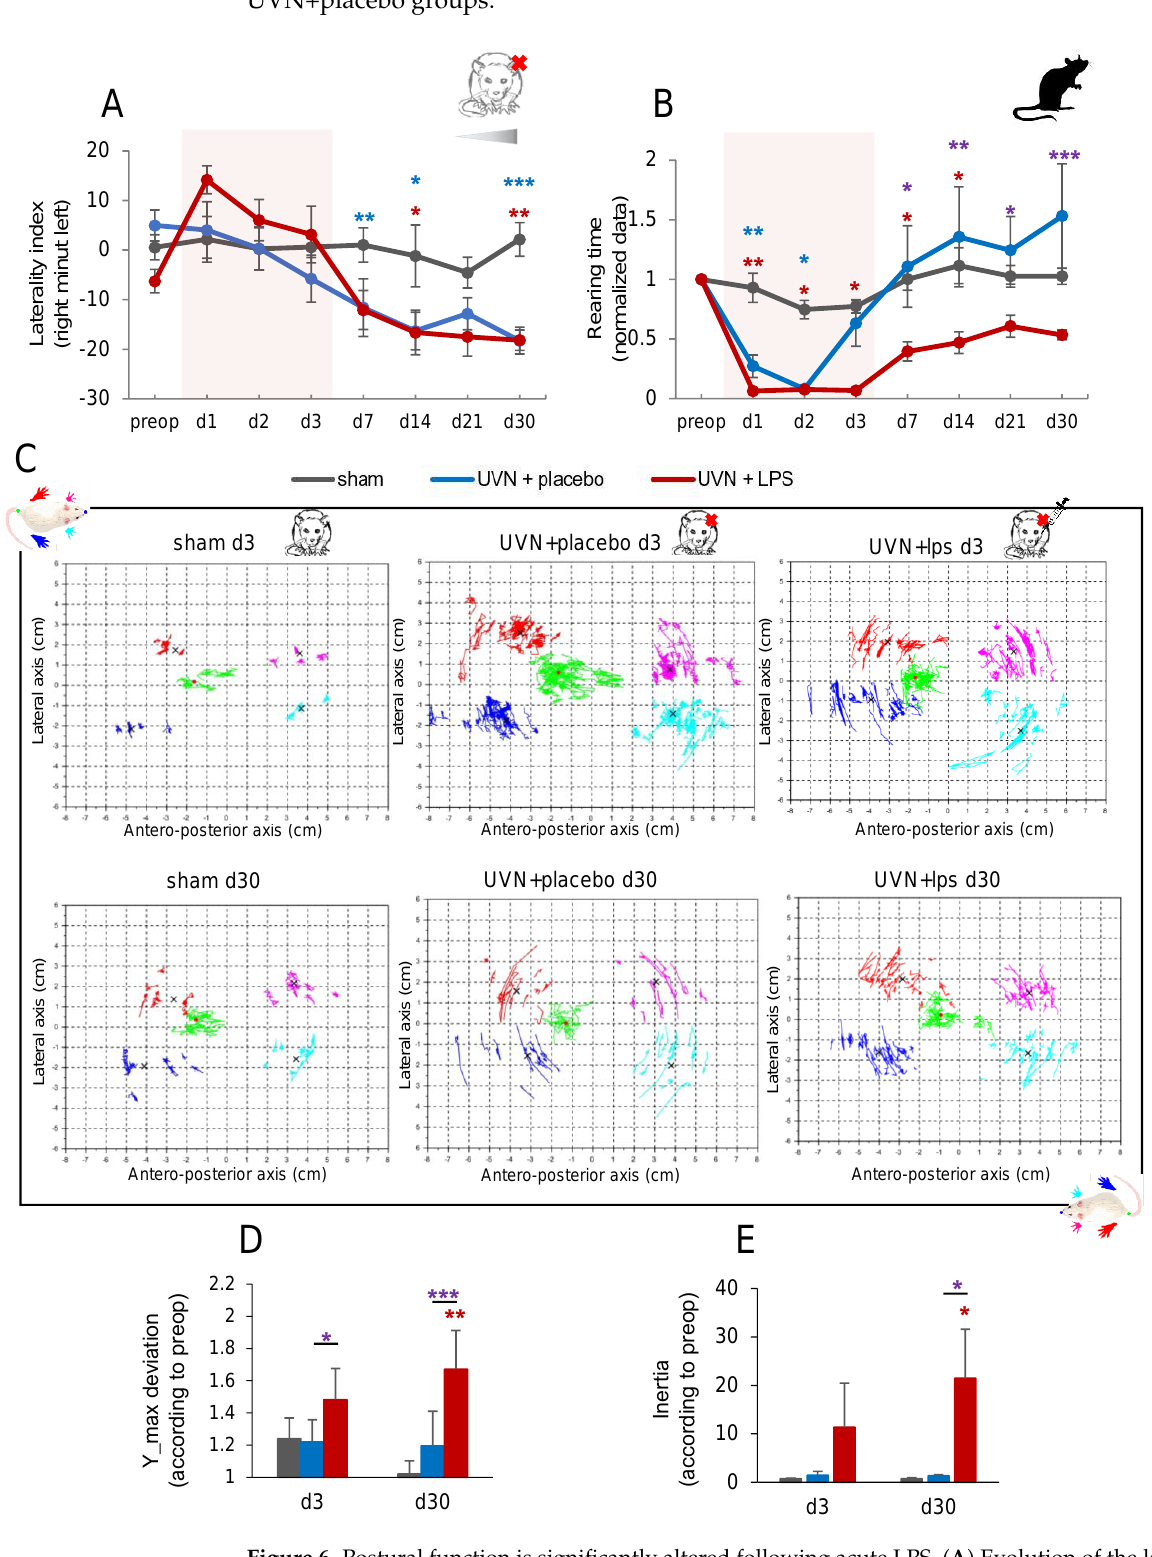
Figure 6. Postural function is significantly altered following acute LPS. ( A ) Evolution of the laterality index. Laterality index represents the lateral weight distribution and is calculated as follows: